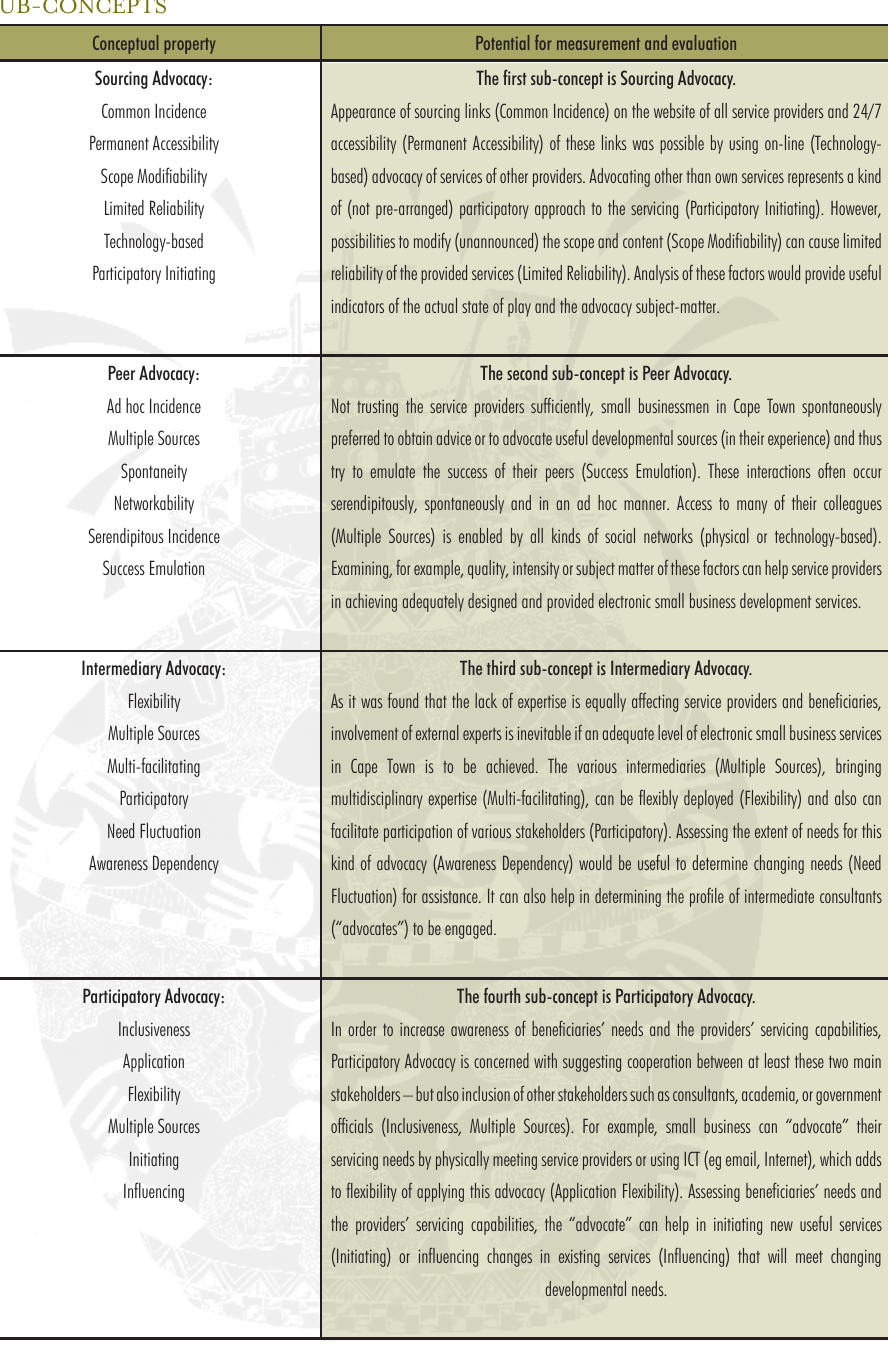
TABLE 2: BASIC CONCEPTUAL PROPERTIES OF SERVICING ADVOCACY AND ITS